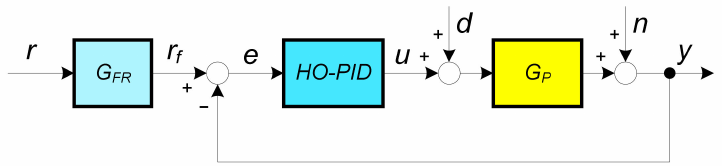
Figure 1. The control loop with HO-PID controller and the